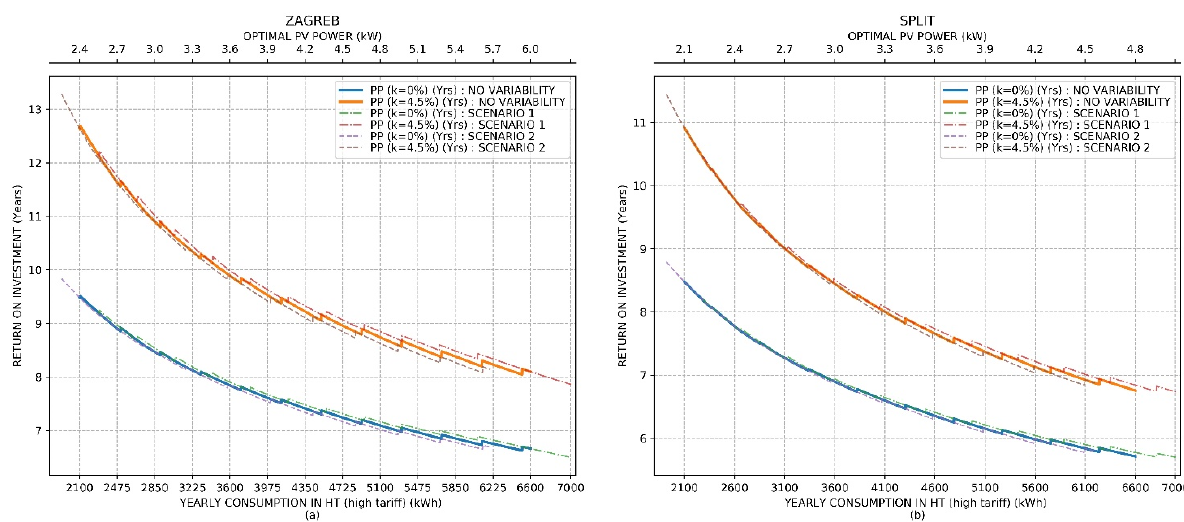
Figure 11. Simulation results of the payback period for a PV system project with discount rates of 0% and 4.5%. ( a ) Simulation results for Zagreb. ( b ) Simulation results for Split.